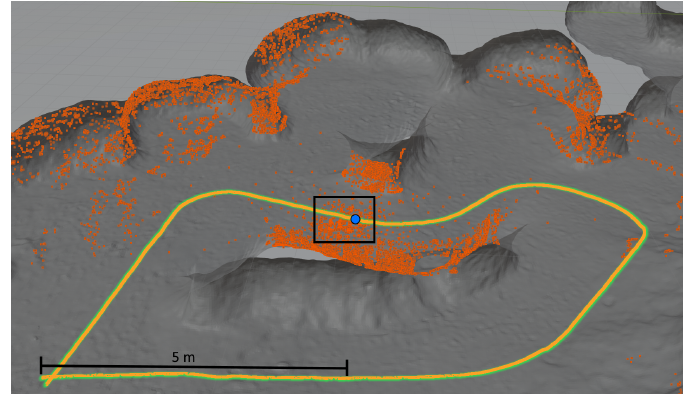
Figure 8. Horizontal cross-section of the point cloud from the cave. The figure shows the reference scan (gray surface), the measured path of the robot (yellow curve), reference path (green line), 50,000 scan points captured in 0.1 s during localization (orange dots), localization of the robot when LiDAR was capturing measurement points (blue point), the approximate location of the zoomed view shown in Figure 9 (black